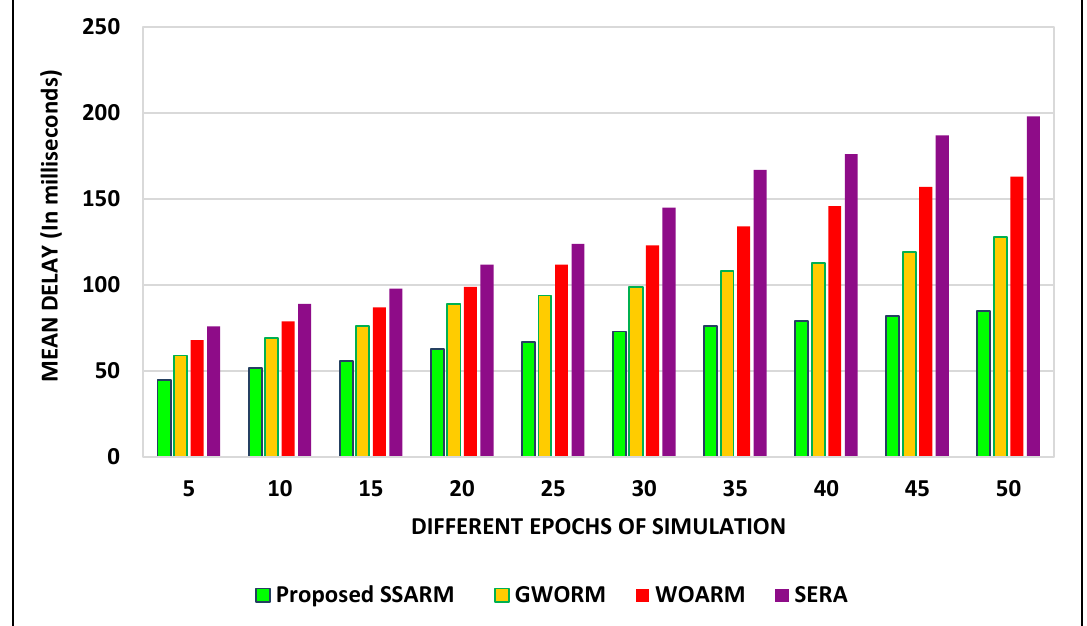
Figure 8. Proposed SSARM-Mean Delay with Different Epochs of